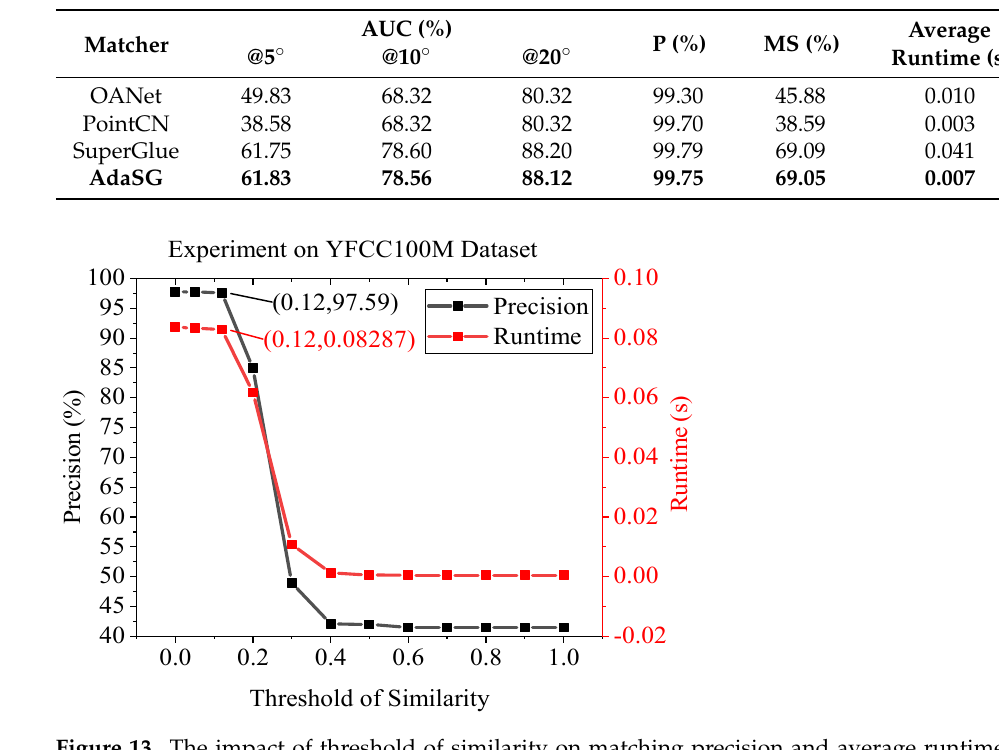
Figure 12. The visualized matching result on KITTI. The red lines represent mismatches, and the green lines represent correct matching. ( a ) The results of OANet. ( b ) The results of SuperGlue. ( c ) The results of AdaSG. ( d ) The other results of OANet. ( e ) The other results of SuperGlue. ( f ) The other results of AdaSG. Table 4. Outdoor Experiment on KITTI Dataset.